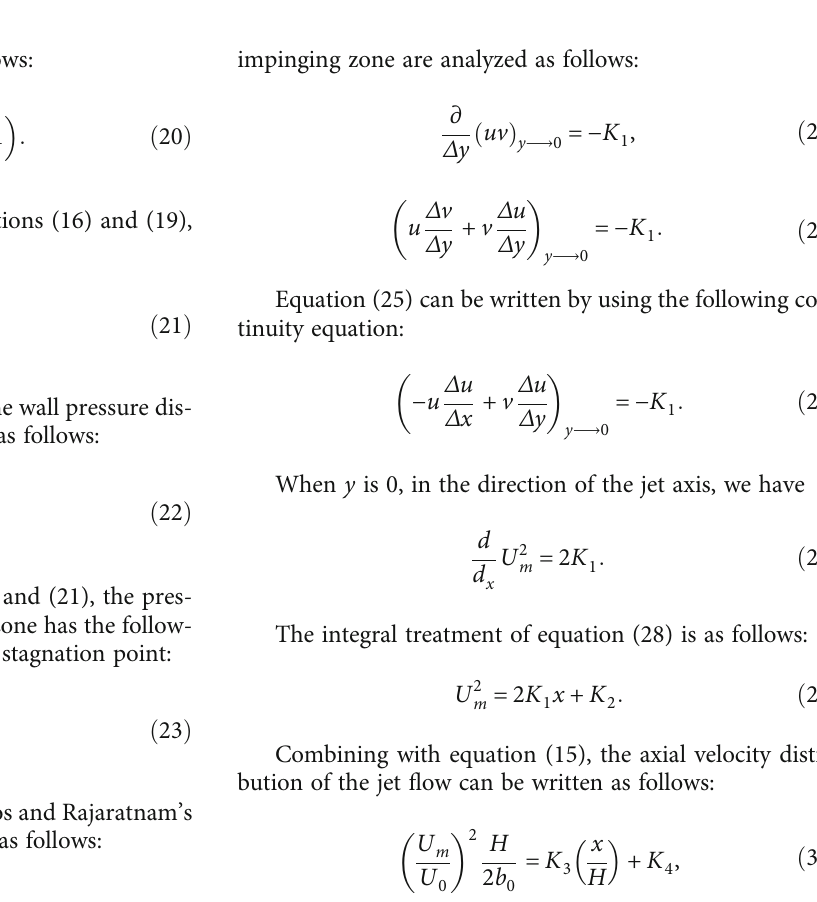
Figure 4: The coordinate system of gas jet development